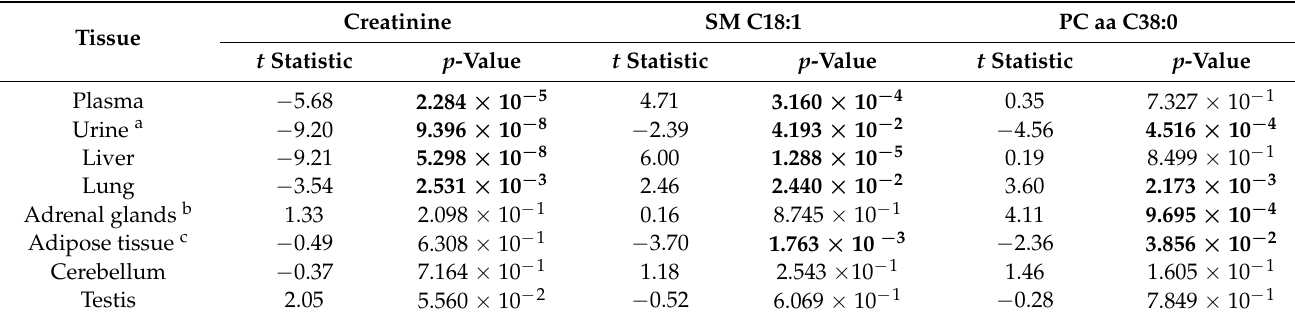
a For SM C18:1, n = 7 in db/db, n = 9 in WT. For PC aa C38:0 and creatinine, n = 9 in db/db, n = 9 in WT. b For creatinine, n = 9 in db/db, n = 9 in WT. c For creatinine, n = 9 in db/db, n = 10 in WT.